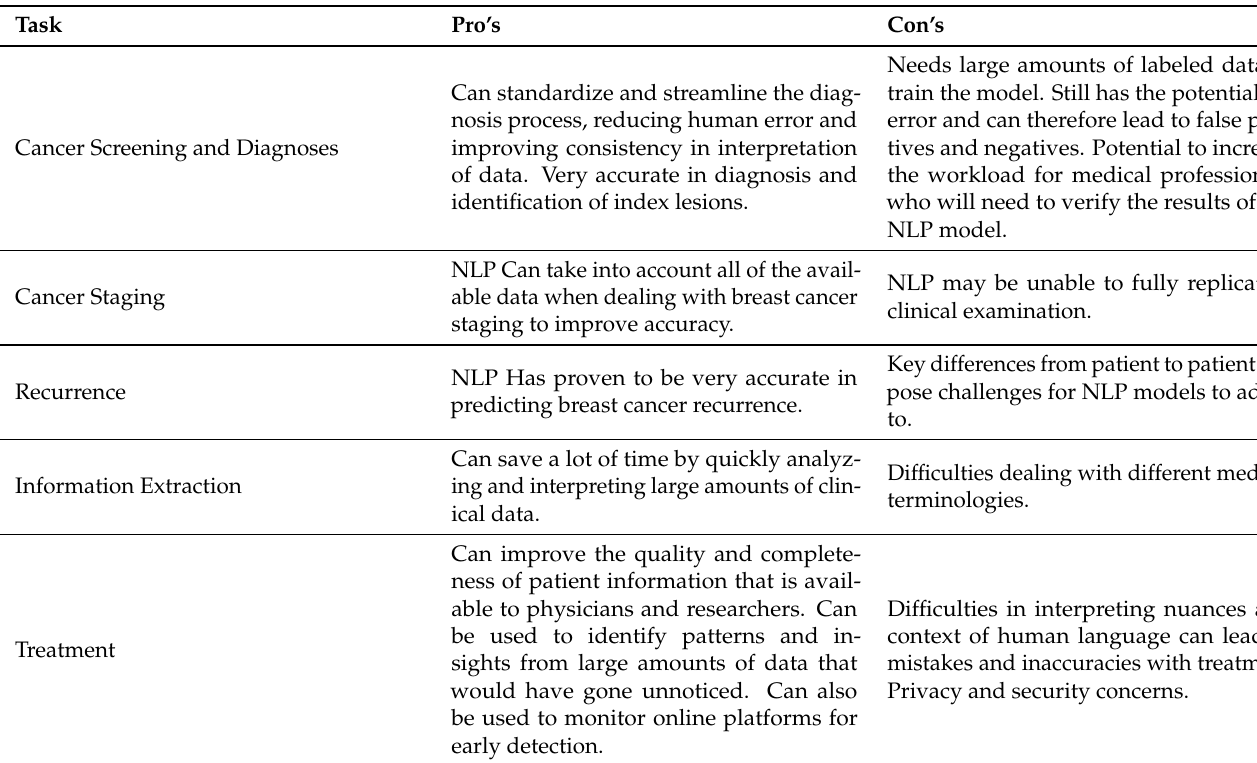
Table 3. Summary of pros and cons in the reviewed NLP